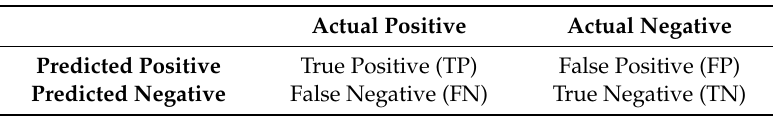
Table 3. Confusion